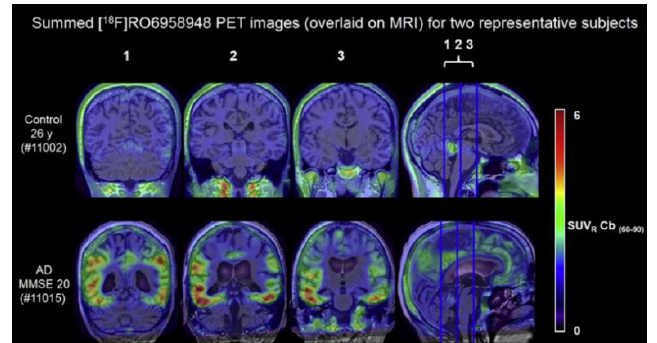
Figure 7. (18F)RO-948 PET images overlaid on MRI on a healthy control (upper row) and an AD patient (bottom row). The increased uptake of (18F)RO-948 in the AD patient is associated with the binding to the hyperphosphorylated tau protein. [80]. Images are reprinted with permission of the publisher [80]. All molecular probes used for 18F PET tau imaging are shown in Table 2. Molecular probes for the detection of Aβ or NFTs using PET.